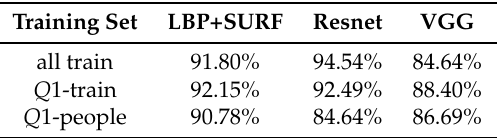
Table 5. Comparison of the performance achieved with models trained using a either all the images available or a subset of images selected according to their coverage. The performance shown is the one achieved when the SVM classifies the Q1-testing